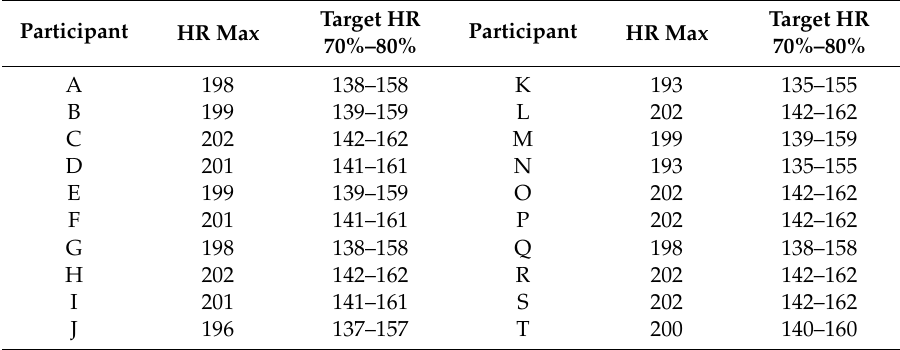
Table 1. Maximum heart rate and target heart